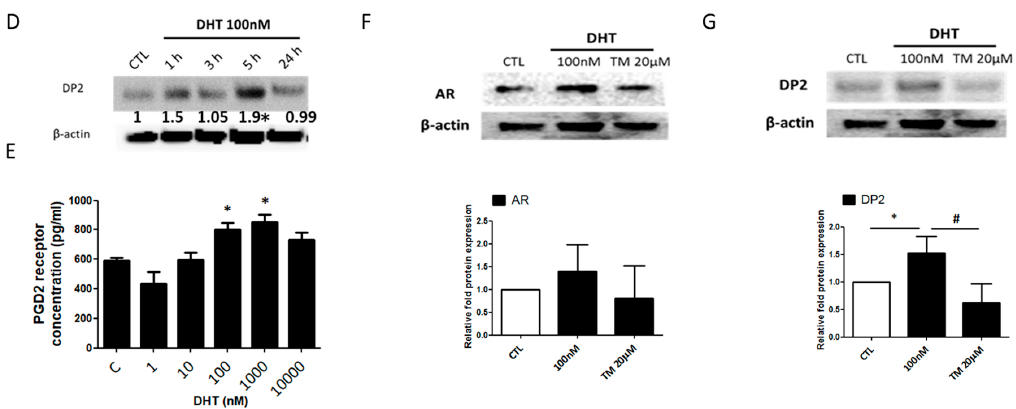
Figure 1. Prostaglandin D2 receptor (DP2) antagonist (TM30089) decreases dihydrotestosterone (DHT)-induced androgen receptor (AR) and prostaglandin expression in human dermal papilla cells (hDPCs). The mRNA expression of cyclooxygenase-2 (COX2), prostaglandin D2 synthase (PTGDS) and DP2 was examined in hDPCs treated with DHT for 24 h. The mRNA expression of COX2 ( A ), PTGDS ( B ) and DP2 ( C ) was induced by 100 nM DHT. DP2 protein expression was strongly induced by 100 nM DHT at 5 h ( D ). hDPCs were cultured for 24 h with DHT, as indicated. The level of PGD2 receptor in the supernatant was evaluated in three independent experiments ( E ). The relative mRNA levels were normalized to that of GAPDH. hDPCs were pretreated with 20 μ M TM30089 for 1 h and then treated with 100 nM DHT for 5 h. The protein level of AR ( F ) and DP2 ( G ) was measured by western blot. TM30089 decreased the DHT-induced AR and DP2 expression. β -actin served as a loading control for protein normalization. The results are expressed as the mean ± SD of three independent experiments: CTL; control. * p < 0.05 compared with the control (0 nM DHT). # p < 0.05 compared with the DHT 100 nM.